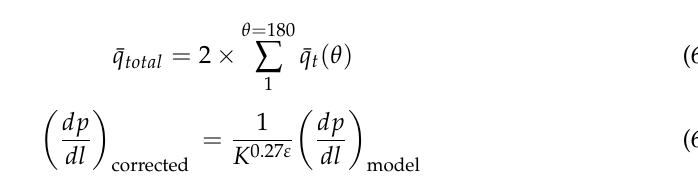
Table 4. The variables used in the model by Srivastav et al.